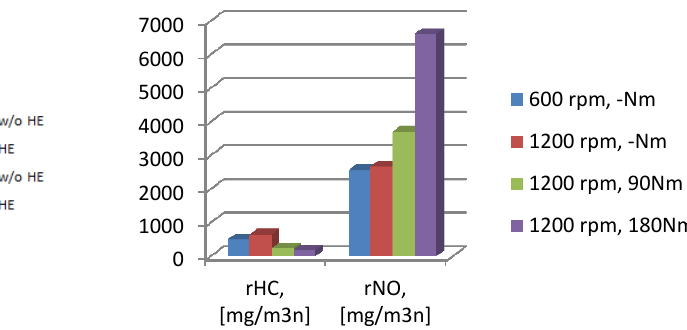
Fig. 10. Amount of CO after warming up (HE – with heat exchanger; w/o HE – without heat exchanger)